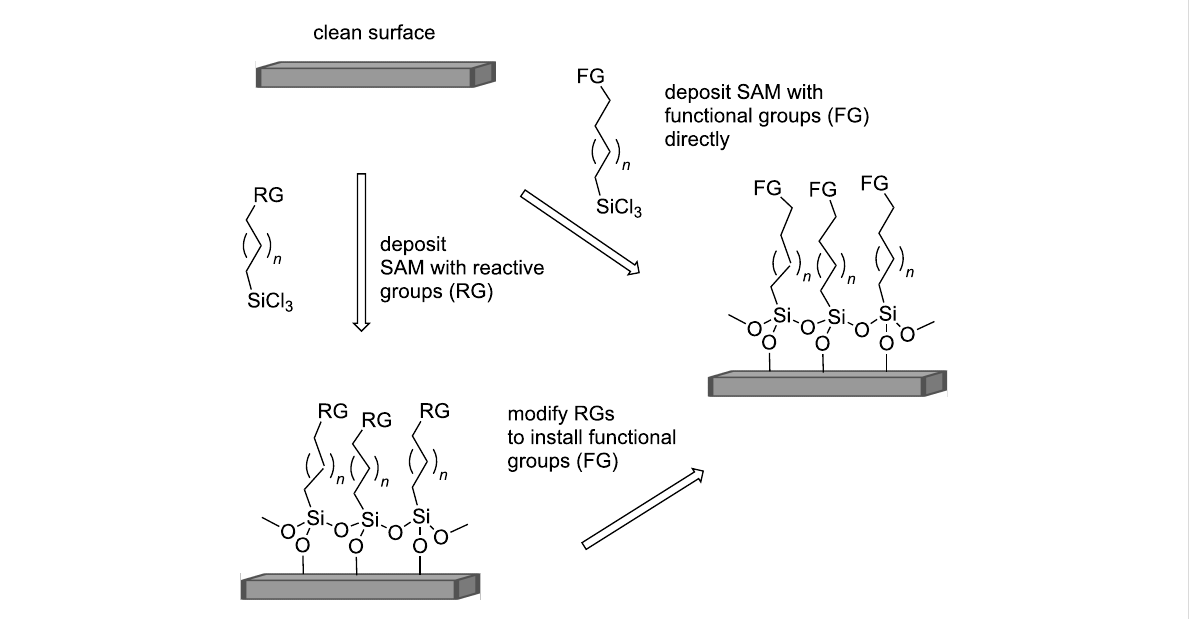
Figure 1: General strategies for incorporating functional groups (FGs) on the surface of self-assembled monolayers (SAMs), illustrated for alkylsi- lanes onto silica.